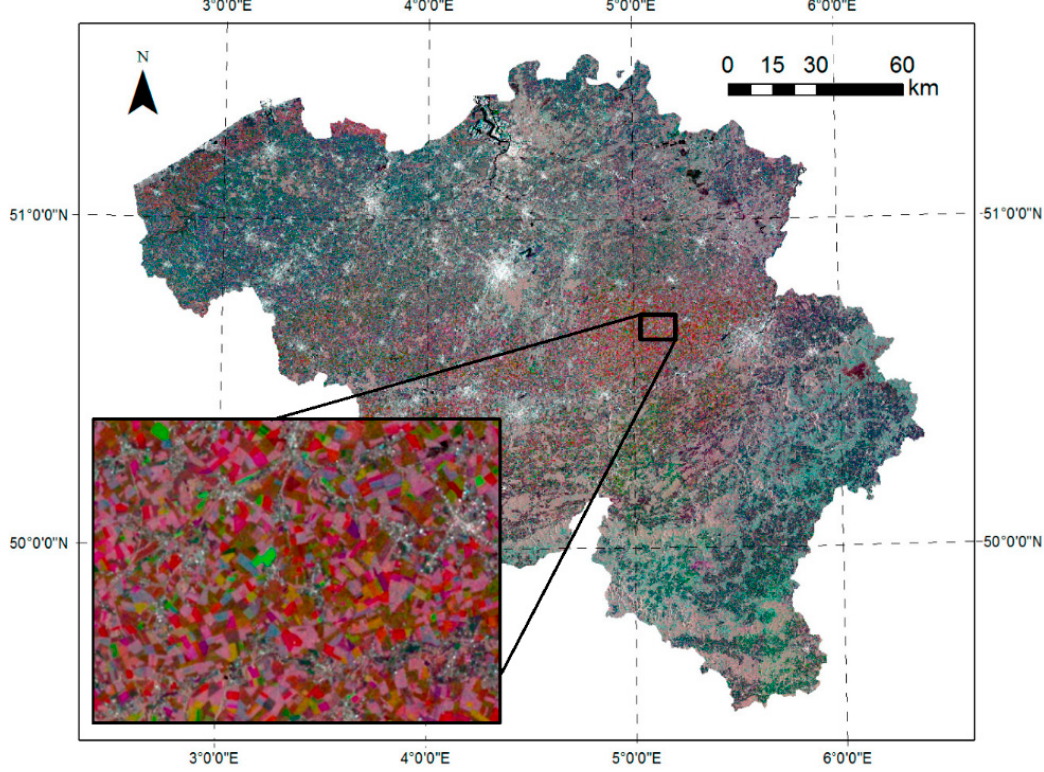
Figure 2. RGB composite of 12-day Sentinel-1 VH backscatter mosaics. 1–13 March 2017 (red), 17–29 June 2017 (green), and 16–28 August 2017 (blue). Inset shows a detailed view of this